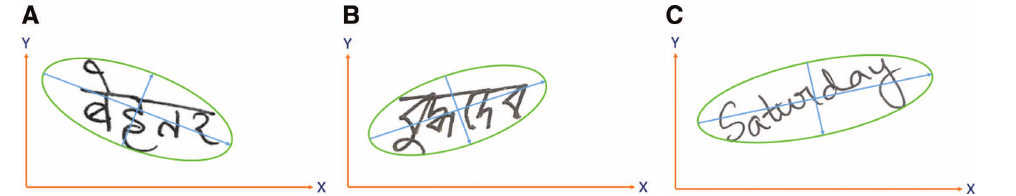
Figure 3: Instances of Erroneous Estimation of Oblique Ellipse Due to (A) Ascendant, (B) Descendant, and (C) Elongated Character